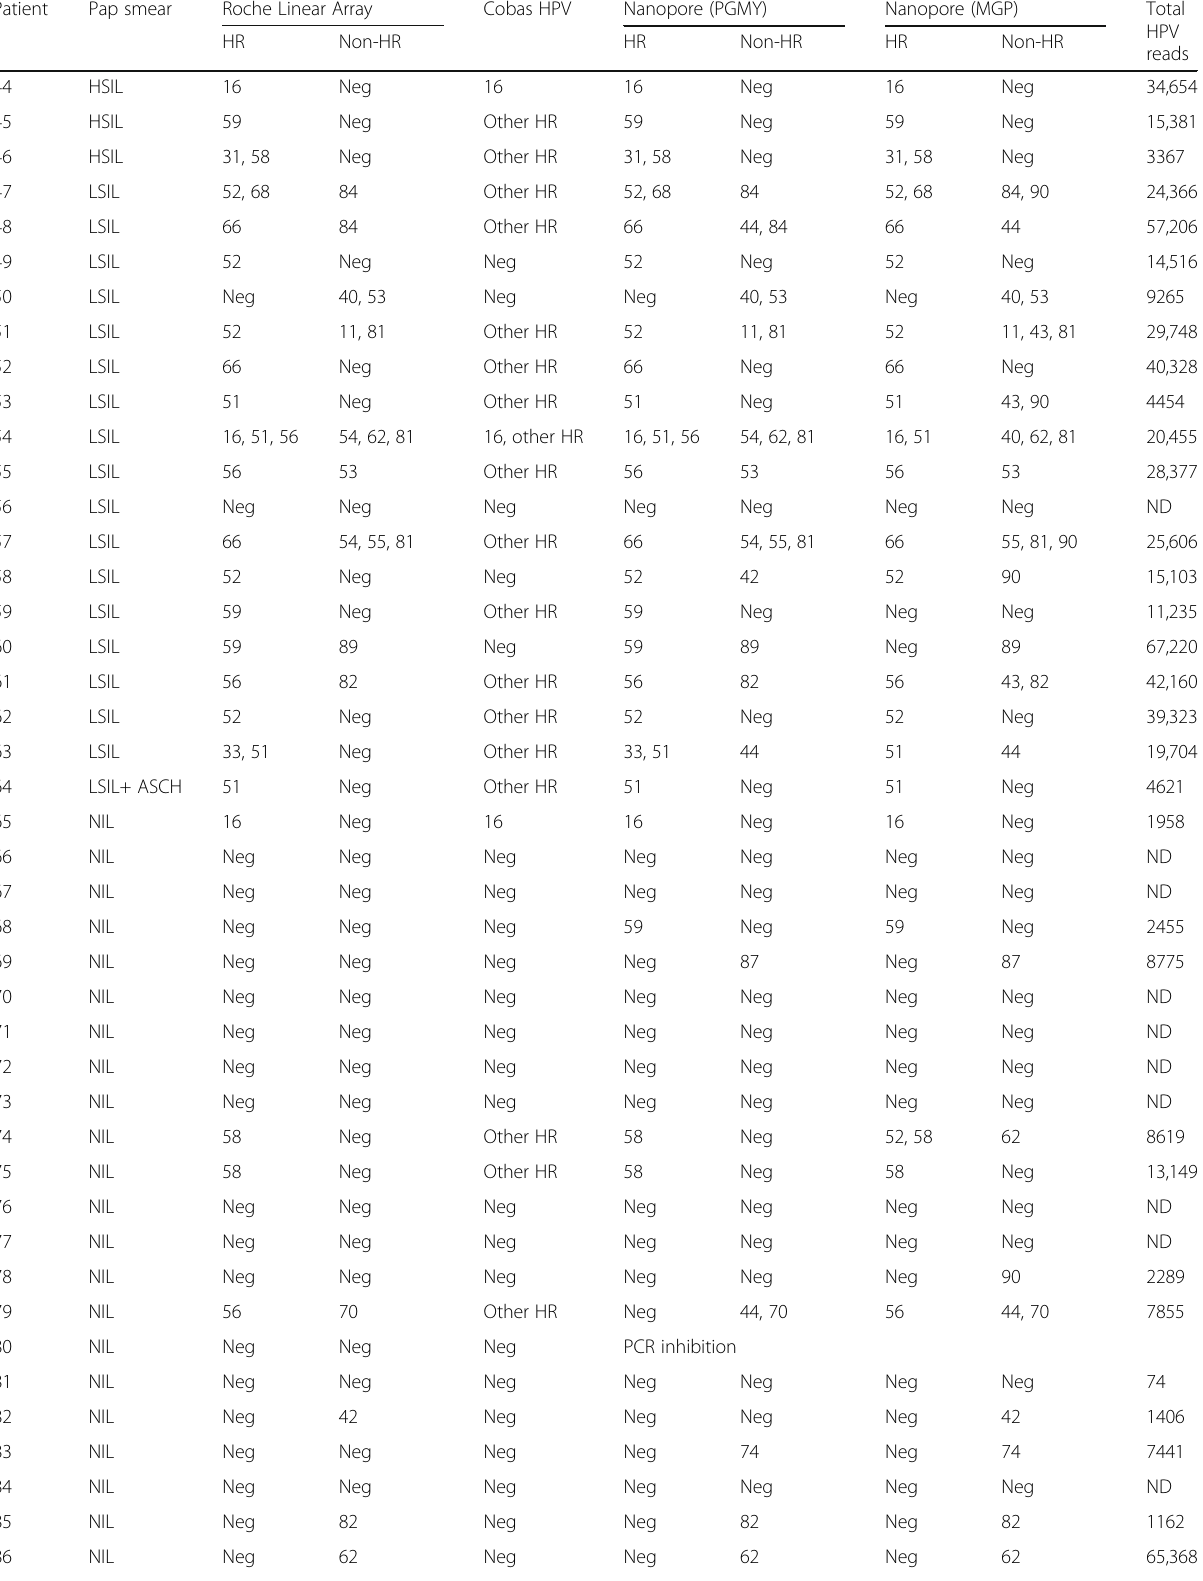
Table 1 Results of Pap smear, cobas HPV Test, Roche Linear Array HPV Genotyping Test, and Nanopore sequencing